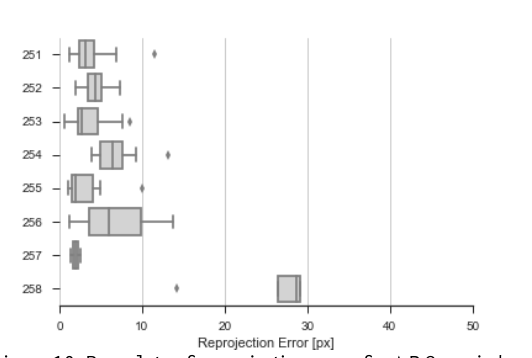
Figure 10. Boxplots of reprojection error for ARCore indoor